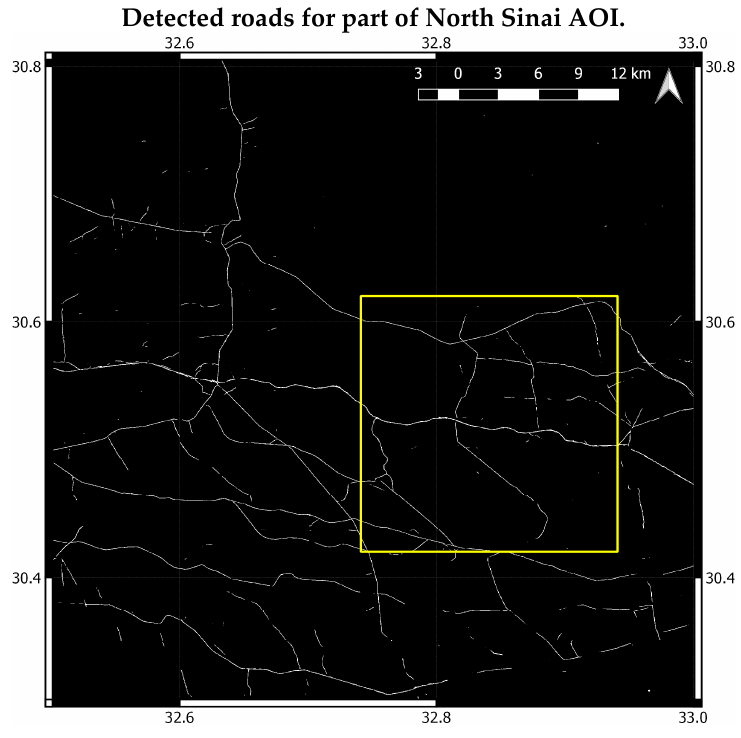
Figure 6. Detected roads for part of the North Sinai AOI. The yellow rectangle shows a 0.2 × 0.2 degree subset over which roads were manually digitised and a performance evaluation carried out. This area is shown in more detail in Figure 7.